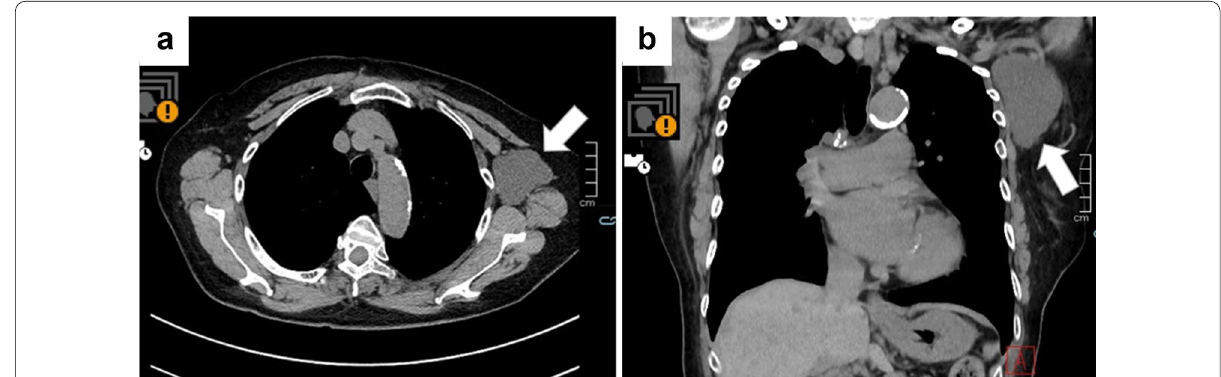
Fig. 1 Non-contrast-enhanced computed tomography (NECT) findings (axial and coronal). Axial ( a ) and coronal ( b ) NECT scans showed a homogeneous, low-attenuation mass in the left axilla. The mass is slightly lobulated